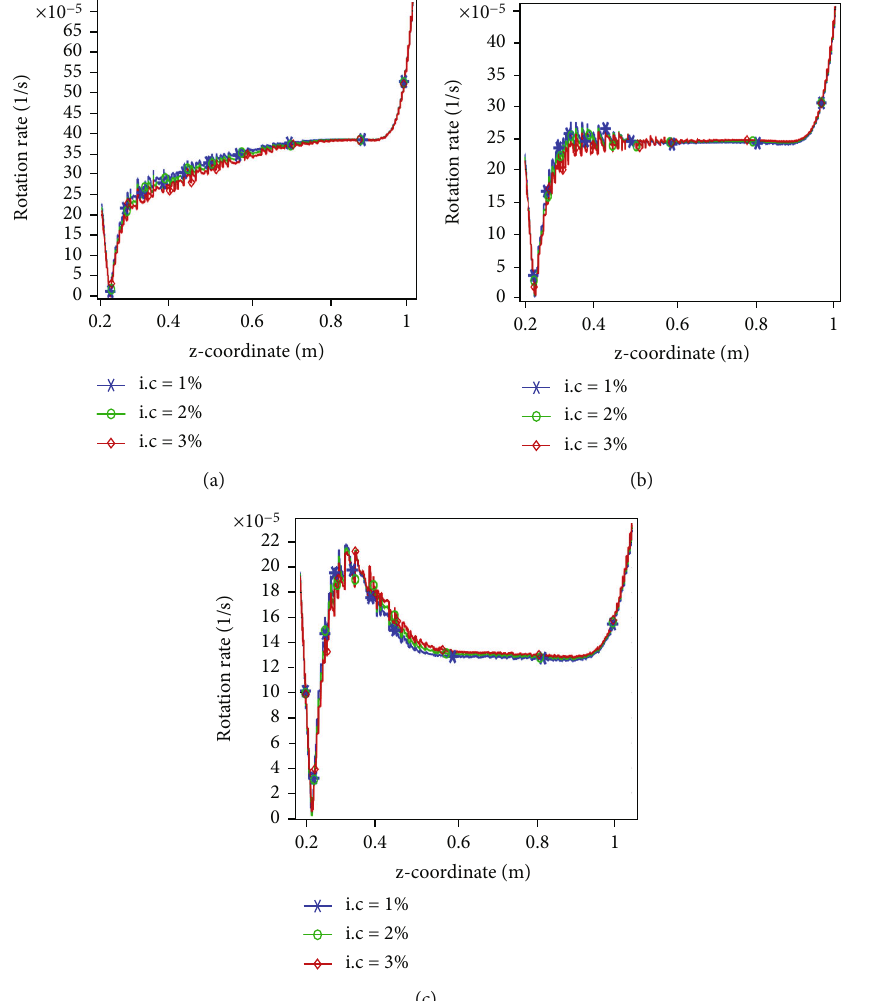
Figure 23: Measurement of rotation rate through the center middle of the downstream of backward step channel for all initial concentration at Re = 100 : (a) a = 0 : 5 , (b) a = 0 : 6 , and (c) a = 0 : 7